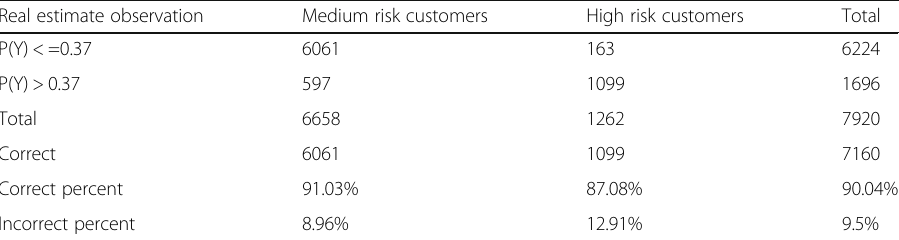
Table 4 Predictive power of the model. This table shows the predicted values of the probability for the dependent variable Y based on being above or below the threshold, in contrast with the actual values observed in the model data. It shows that the degree of sensitivity and degree of diagnosis of ANFIS in the model data were 87.08% and 91.03%, respectively